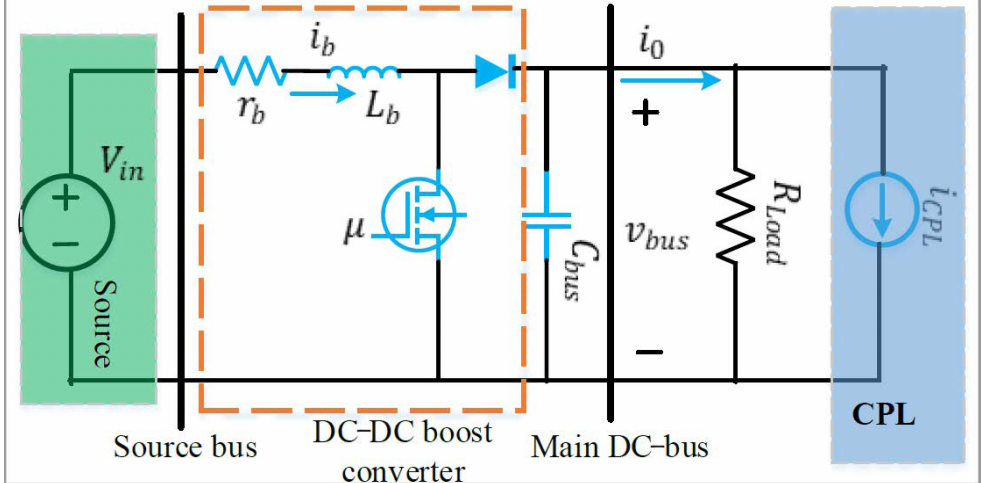
Figure 2. The simplified structure of a DDBC feeding a